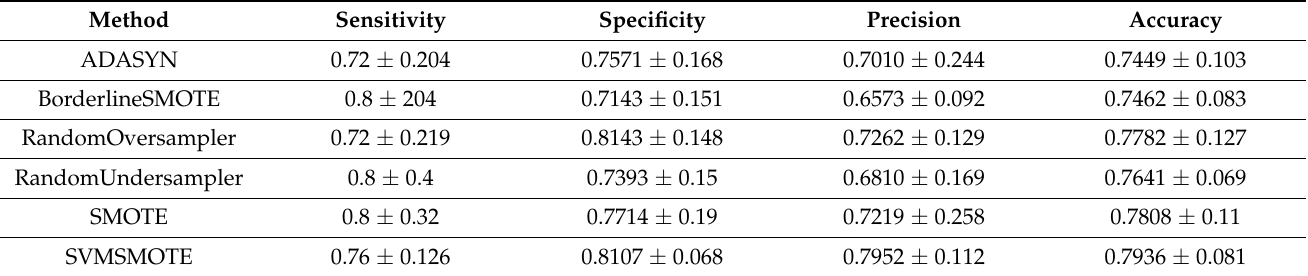
Table 3. Comparative performance among different sampling strategies in predicting TMB group using